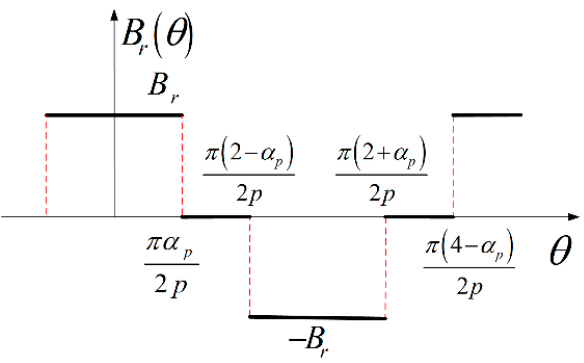
( ) Figure 8. Distribution of B r ( θ ) . B θ . Figure 8. Distribution of r It is assumed that the flux generated by the PM passes through the air gap in the radial direction and then enters the claw pole slot along the circular trajectory, as shown in Figure 9. The effective air gap length within half the claw pole slot distance can be thus expressed as